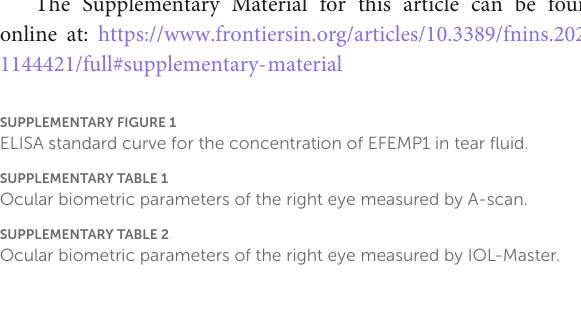
SUPPLEMENTARYFIGURE1 ELISA standard curve for the concentration of EFEMP1 in tear fluid. SUPPLEMENTARYTABLE1 Ocular biometric parameters of the right eye measured by A-scan. SUPPLEMENTARYTABLE2 Ocular biometric parameters of the right eye measured by